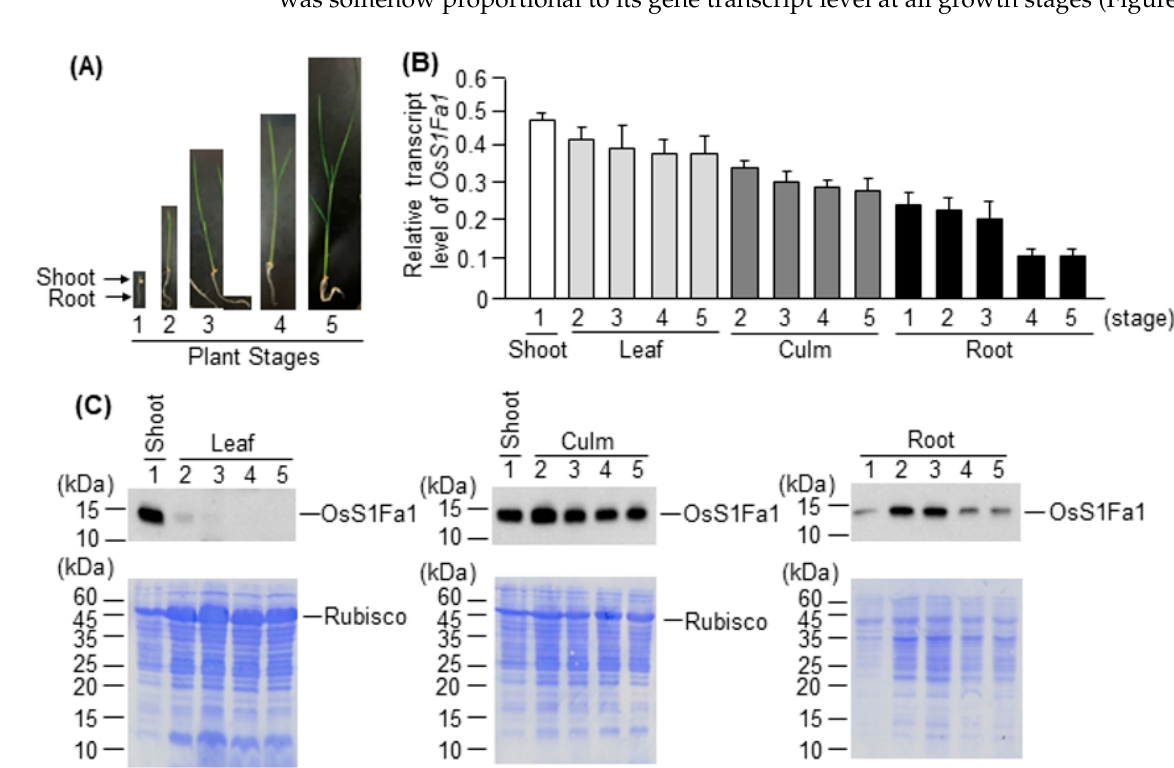
Figure 3. Analysis of OsS1Fa1 transcript level and the corresponding protein level in different tissues of rice seedlings at different development stages. ( A ) Photographs showing rice seedlings at five different developmental stages. ( B ) RT-qPCR analysis of OsS1Fa1 expression in the leaf, culm, and root tissues of rice seedlings at different developmental stages. Stage 1, one leaf (7-d-old seedlings); stage 2, two leaves (10-d-old seedlings); stage 3, three leaves (13-d-old seedlings); stage 4, four leaves (19-d-old seedlings); stage 5, five leaves (21-d-old seedlings). Data represent mean ± SD ( n = 3). ( C ) Western blot analysis of the OsS1Fa1 protein using anti-OsS1Fa1 antibody. Total proteins were extracted from the same samples used in ( B ). Corresponding protein gels are shown below.